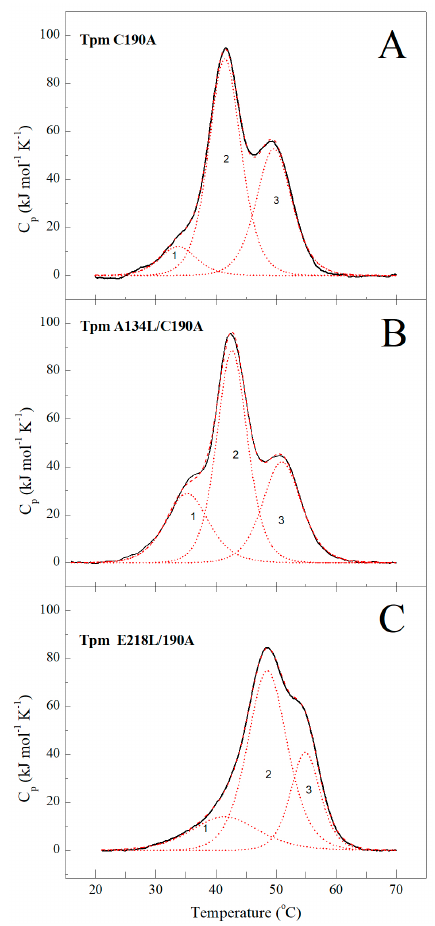
Figure 2. Heat sorption curves and deconvolution analysis of DSC profiles for A134L / C190A ( B ) and E218L / C190A ( C ) mutants in comparison with control C190A Tpm ( A ). Solid lines represent the experimental curves after subtraction of chemical and instrumental baselines, dotted curves represent the calorimetric domains obtained from experimental data by analysis with the non-two-state model. The experiments were done at a constant heating rate of 1 K / min and protein concentration 2 mg / mL. Table 1. Calorimetric parameters obtained from the di ff erential scanning calorimetry (DSC) data for individual thermal transitions (calorimetric domains) of Tpm mutants and parameters of thermostability of the Tpm–F-actin complexes (T diss ).